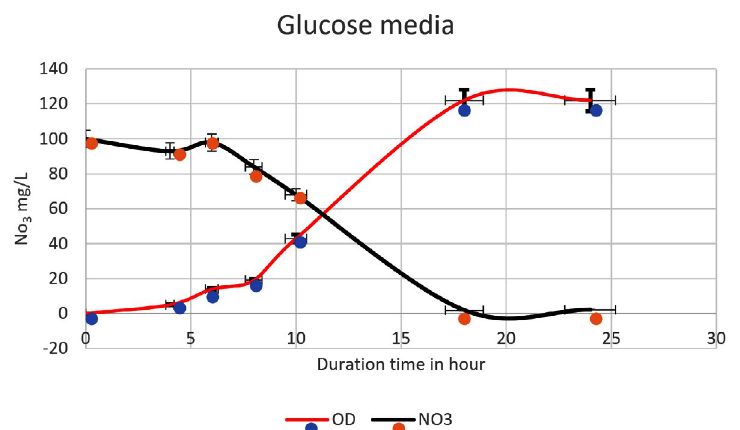
Fig. 4. The nitrate was reduced on mineral media with glucose by Pseudomonas aeruginosa . The higher reduction of nitrate was reached at 18 h (1.9mg/L). An inverse relationship was shown in a time course from 0 to 18 h, Nitrate reduction was observed in log phase (the more bacterial growth, the higher the denitrification process).